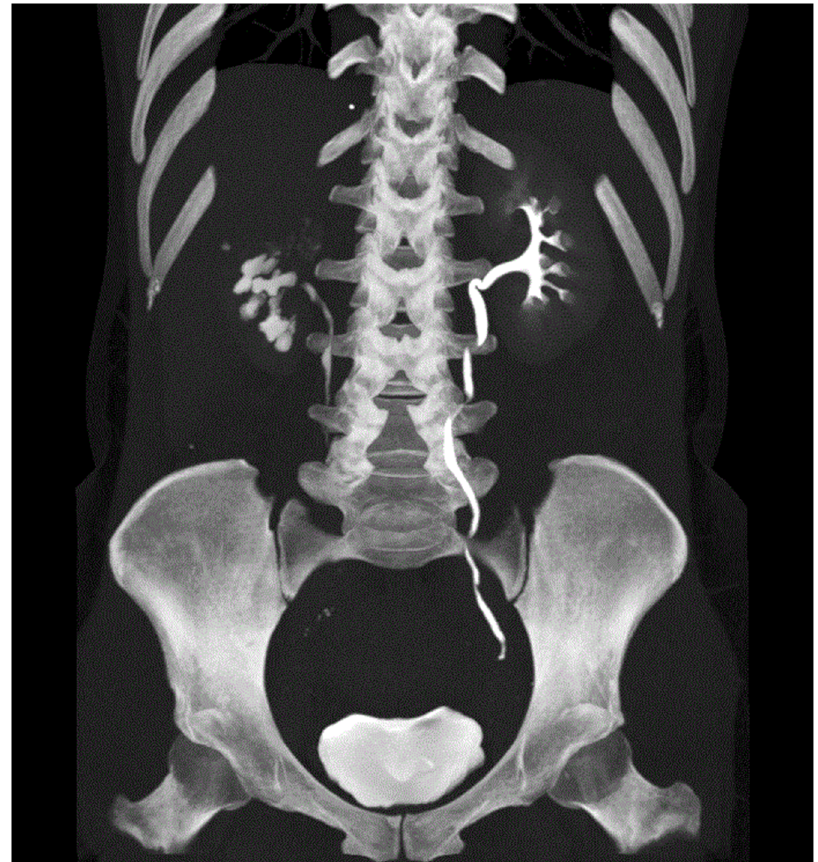
Figure 4. CT IVU showing right kidney delayed excretion and left ureter with multiple kinking and stenosis.